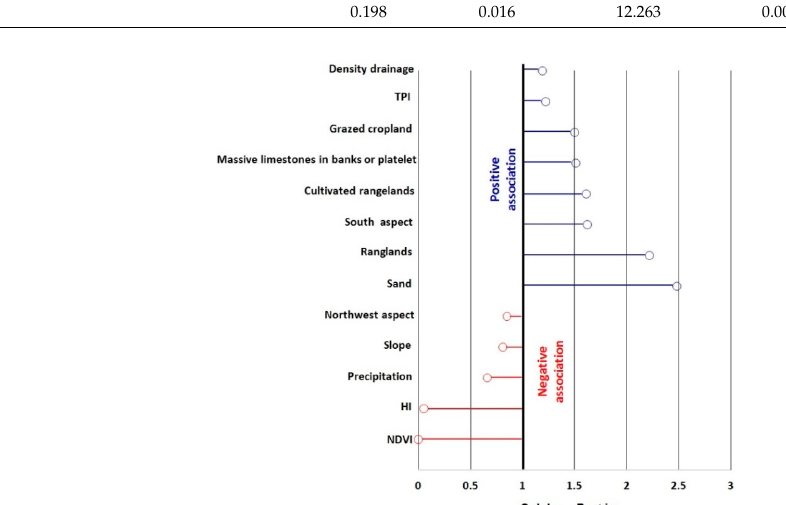
Figure 4. The predictive factors retained in the final logistic model and their odds ratios.